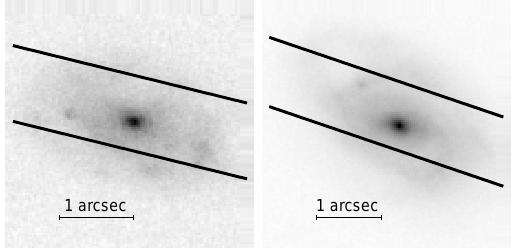
Fig. 1. Photometric images of two galaxies (left TKRS 2568, right TKRS 9059) in the z (cid:12)lter, with the positions of the spectrograph slit over-